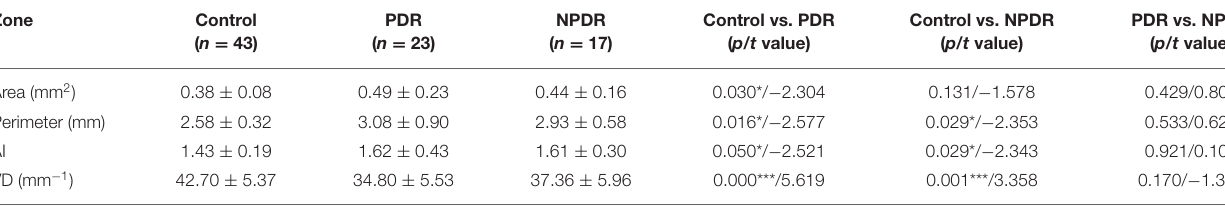
TABLE 1 | SS-OCTA evaluated the FAZ with centered on the macular fovea in control eyes, PDR eyes, NPDR eyes (mean ± SD, p -value). Zone